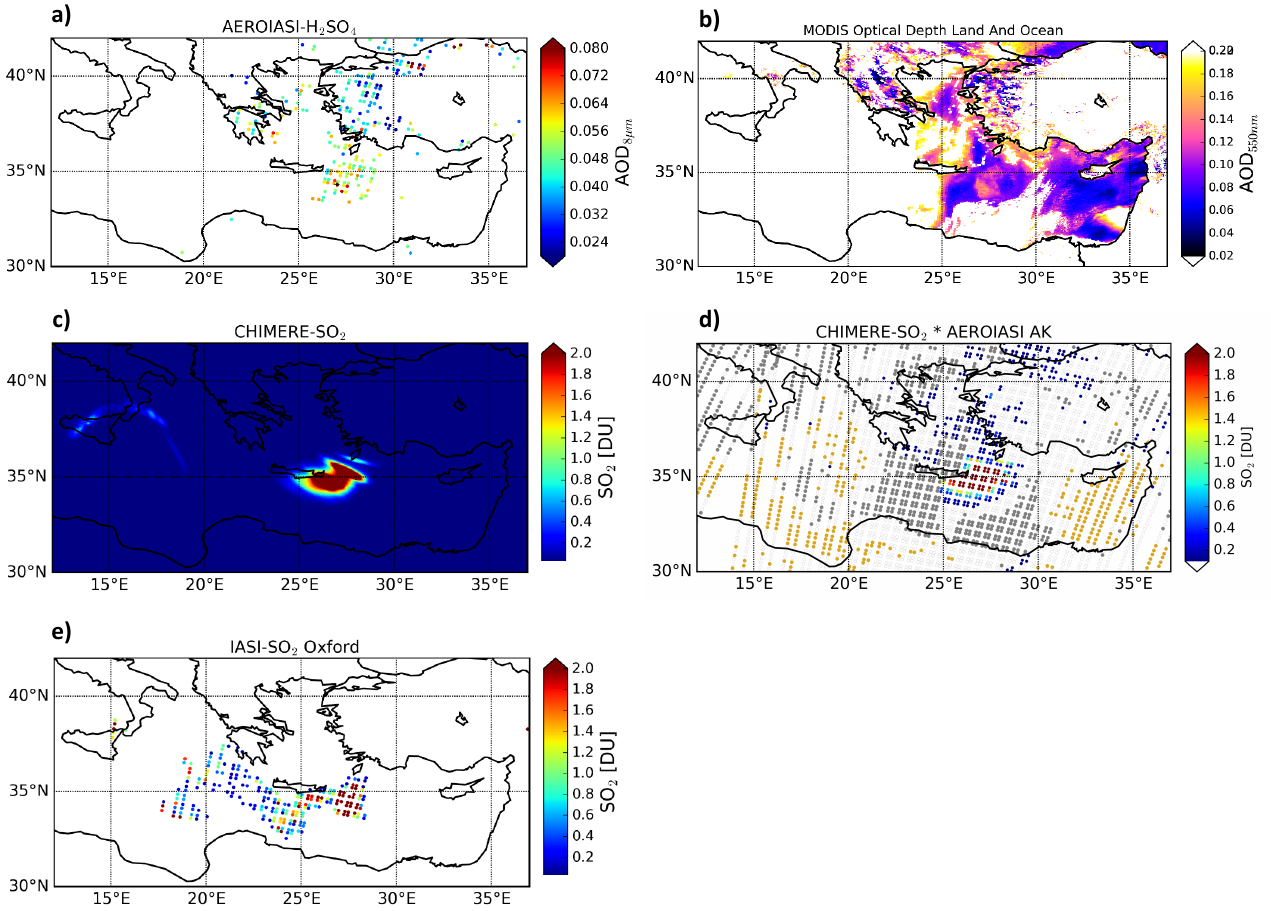
Figure 3. ( a ) AEROIASI-H2SO4 AOD retrievals at 8 µ m, on 19 March 2012, morning IASI overpass (approximately 9:30 LT), ( b ) MODIS AOD retrievals at 550 nm, for the same scene as in ( a ) (approximately 1 h later than IASI overpass), ( c , d ) CHIMERE SO 2 raw column amounts and column amounts convolved using AEROIASI-H2SO4 AK and projected on the IASI swath (volcanic-only run in ( c ), volcanic+anthropogenic run in ( d ), at 10:00 LT). Pixels affected by clouds (in grey) and dust (orange) are also shown in ( d ), ( e ) IASI-SO 2 Oxford SO 2 column amounts, for the same IASI overpass as in ( a ). The black cross in ( a ) identifies the pixel of the spectra of Figures 1 and